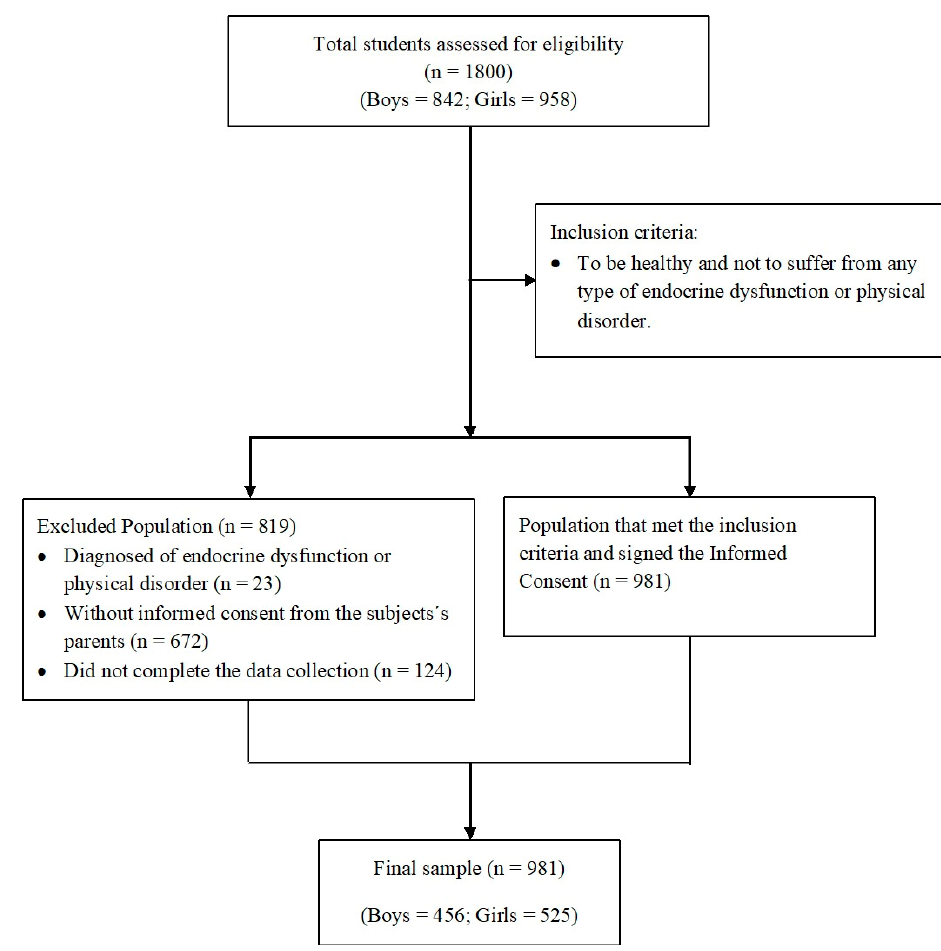
Figure 1. Flow diagram of the recruitment progress.